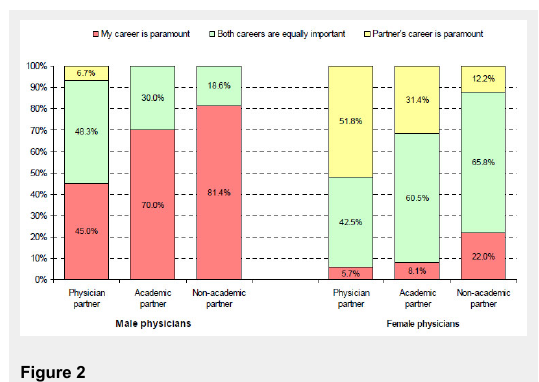
Career priority by gender and partner type.